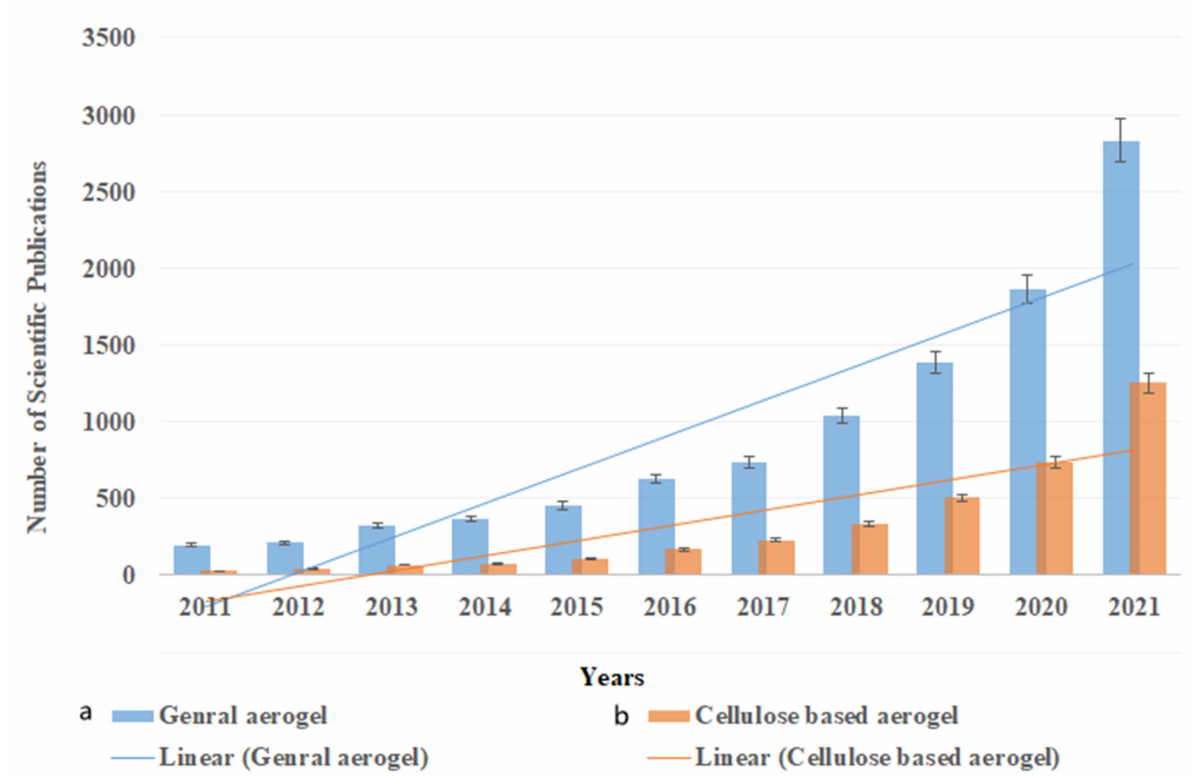
Figure 1. Number of scientific publications in the past 10 years on the use of aerogels as absorbent materials: ( a ) general aerogel; ( b ) cellulose-based aerogel. The research was done using the ScienceDi- rect database on 30 December 2021, using the keywords (Aerogel absorption) for general aerogel and “cellulose aerogel absorption” for cellulose-based